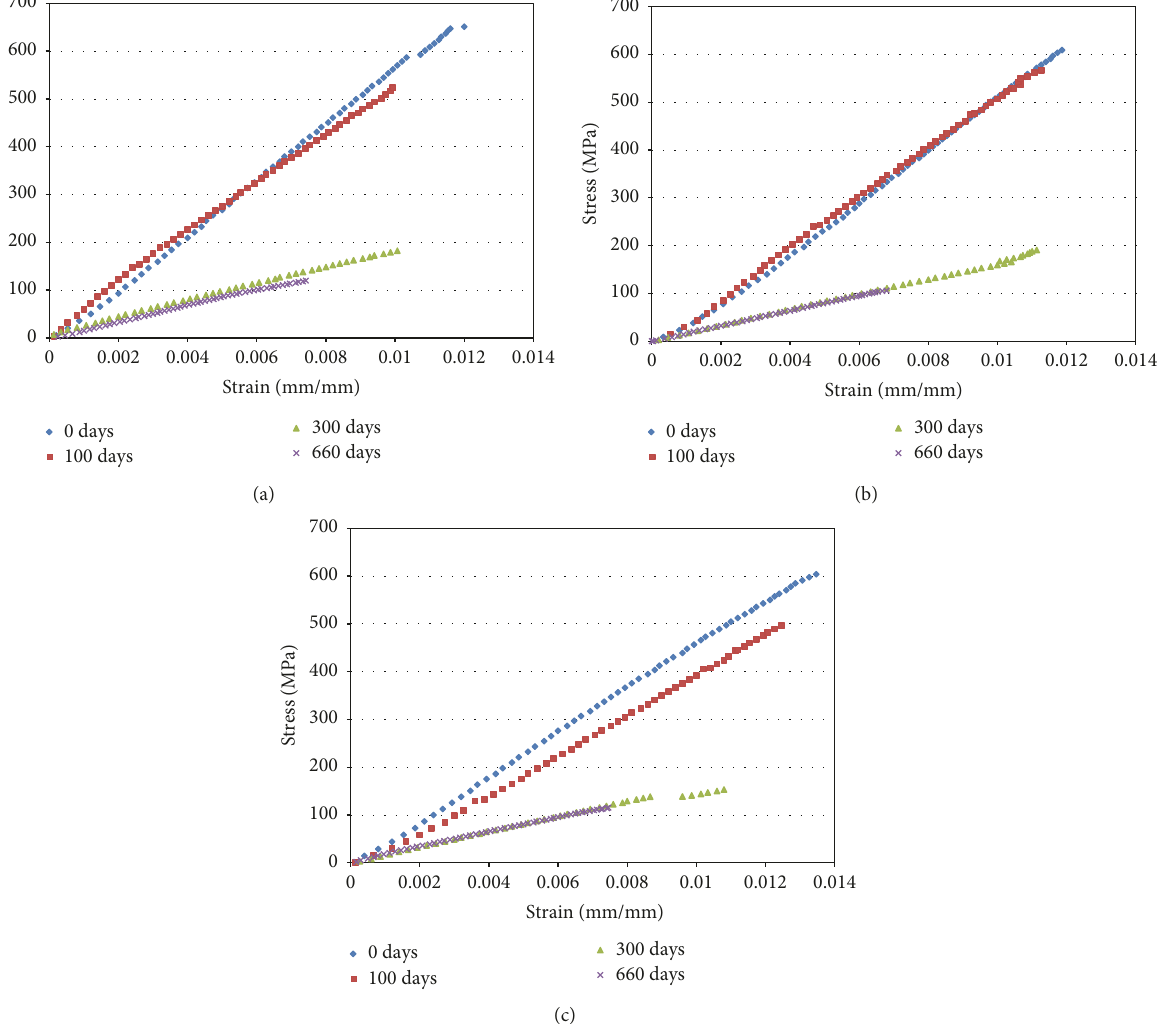
Figure 9: Results of tensile stress-strain curve from experimental test: (a) Ref specimen, (b) PH 120 specimen, and (c) PH 200 specimen.